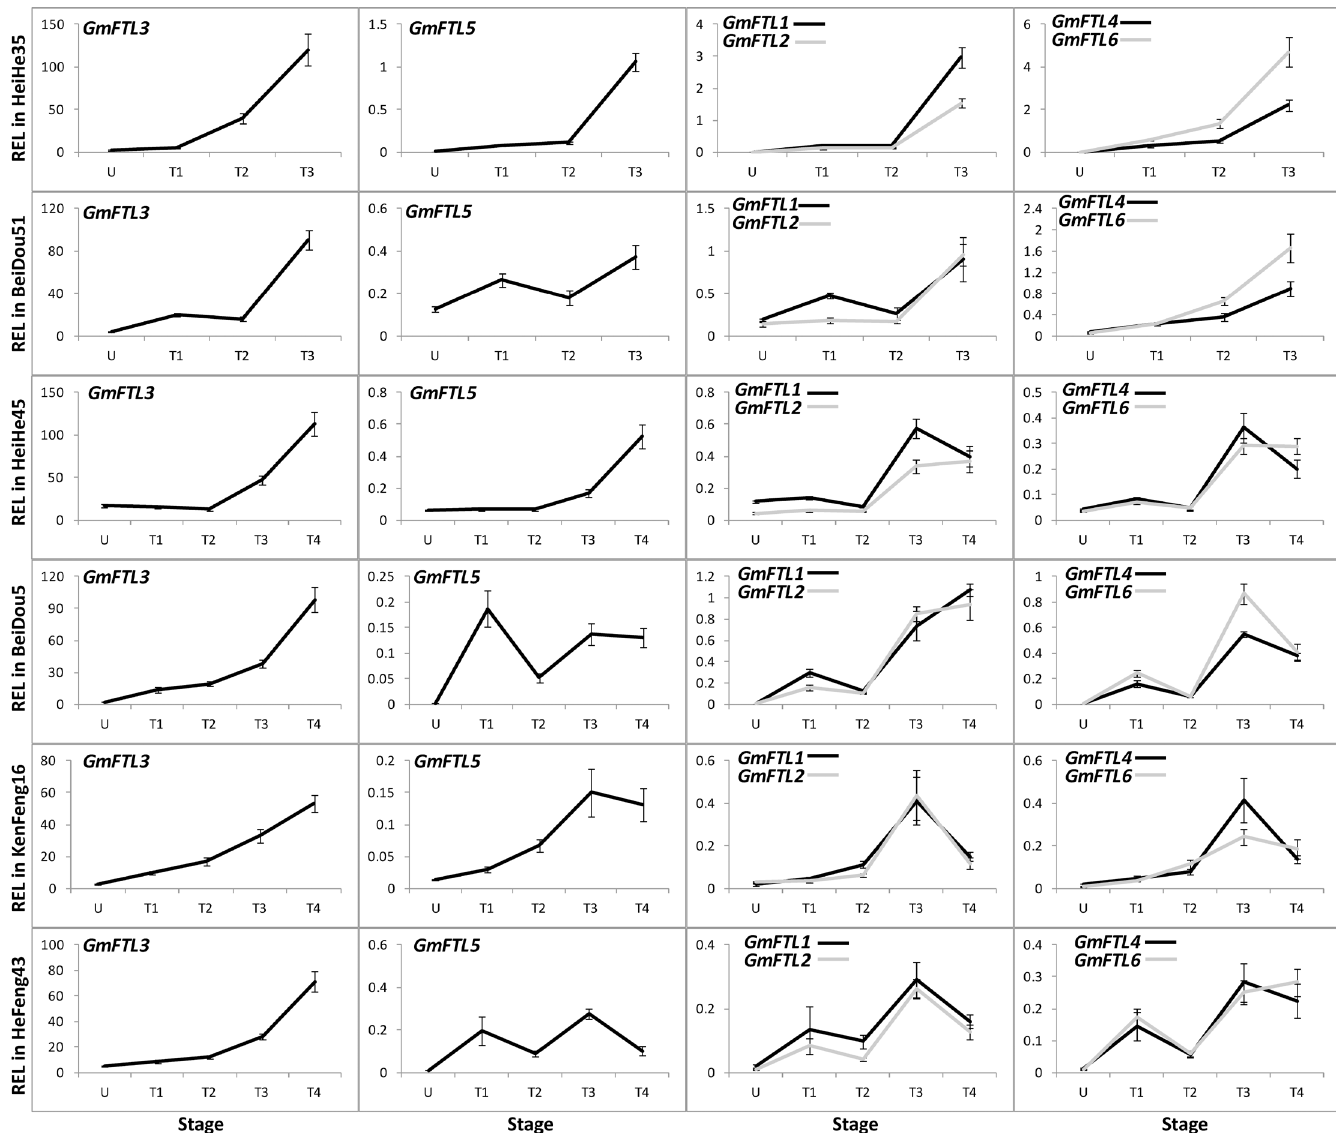
Fig 3. Relative expression levels of GmFTL s in six soybean cultivars at different stages. U, U-stage; T1, T1-stage; T2, T2-stage; T3, T3-stage; T4, T4-stage. Relative expression levels (REL) were analyzed by RT-qPCR and normalized to UKN1 . Averages and standard errors are the result of three replicates. For detailed information on stages and sampling, see Materials and Methods